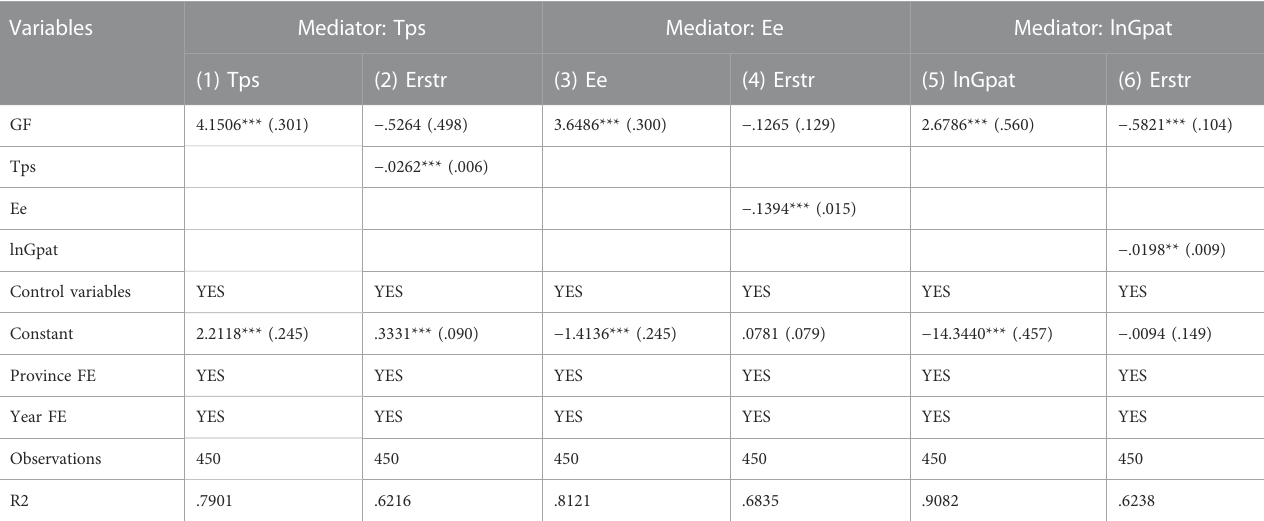
TABLE 6 Mediating